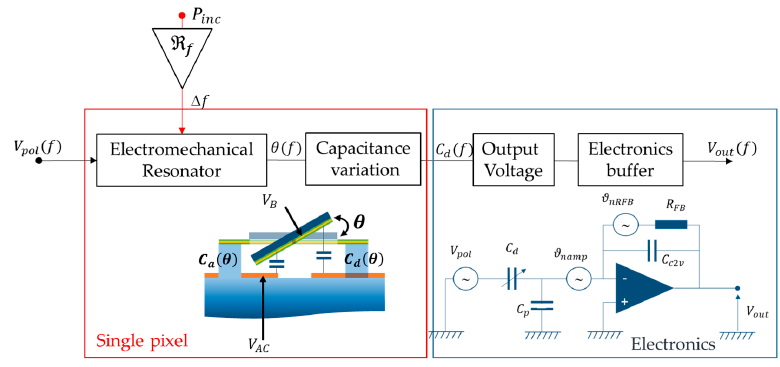
Figure 5. Synopsis of the open ‐ loop measurement chain: The red box corresponds to a single electromechanical pixel that translates the incident IR ‐ radiation P inc on the scene into a resonance frequency shift; the blue box corresponds to the close ‐ by electronics that convert the mechanical oscillations into an electrical signal; V pol is the polarization of the pixel; θ ( f ) is the angular oscillation of the paddle around the rods; Cd ( f ) is the induced capacitance variation used to read out the signal; V out ( f ) is the output signal supplied by the buffer. C p is the total capacitance due to amplifier input capacitance, and parasitic capacitances between the electrical connections and the ground.